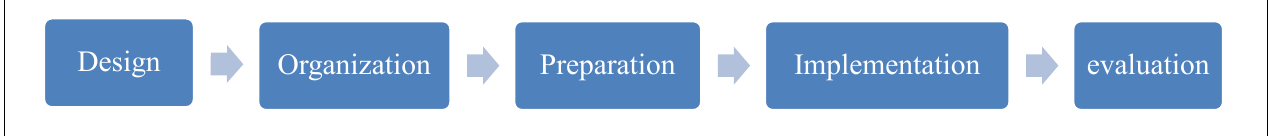
FIGURE 1 | The process for designing and organizing experiential mathematics